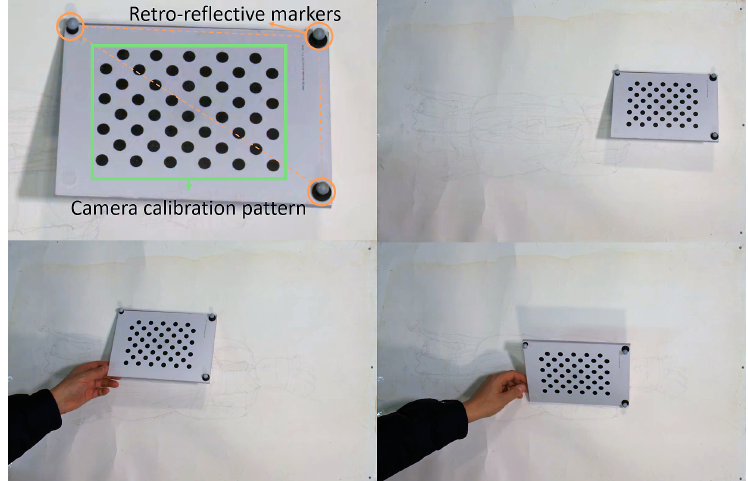
Figure 14. Preliminary data acquisition for the time synchronization between the motion-tracking sensor and the canvas camera. The pattern board contains three retroreflective markers detected by the motion-tracking sensor and a cycle pattern detected by the canvas camera. We repeatedly moved and stopped the pattern board to obtain the respective signals from the two